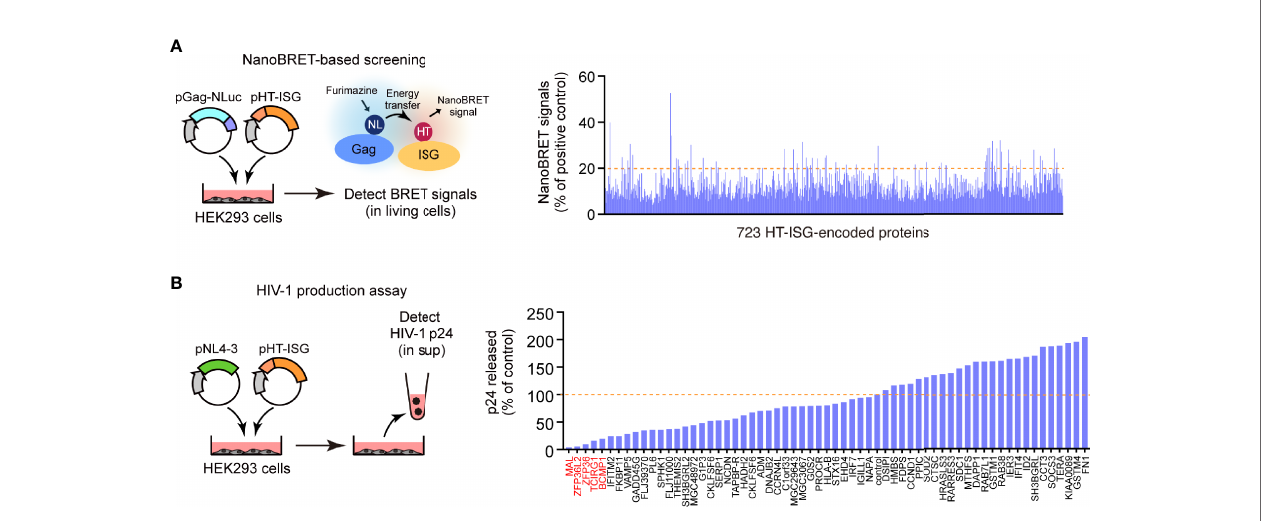
FIGURE 1 | Identi fi cation of Gag-binding proteins that inhibit HIV-1 production. (A) NanoBRET-based screening identi fi ed 723 Gag-interacting proteins encoded by interferon-stimulated genes (ISGs) in HEK293 cells. (B) HIV particle production assay. HEK293 cells were co-transfected with the HIV molecular clone pNL4-3 and ISG-encoded protein expression vectors. Two days post-transfection, viral p24 antigen levels in the culture supernatants were measured by